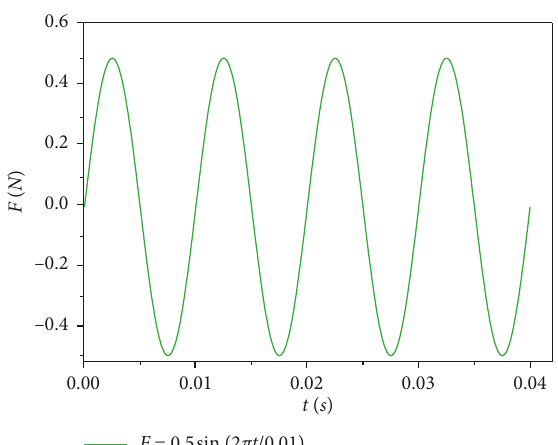
Figure 4: Sine wave load.